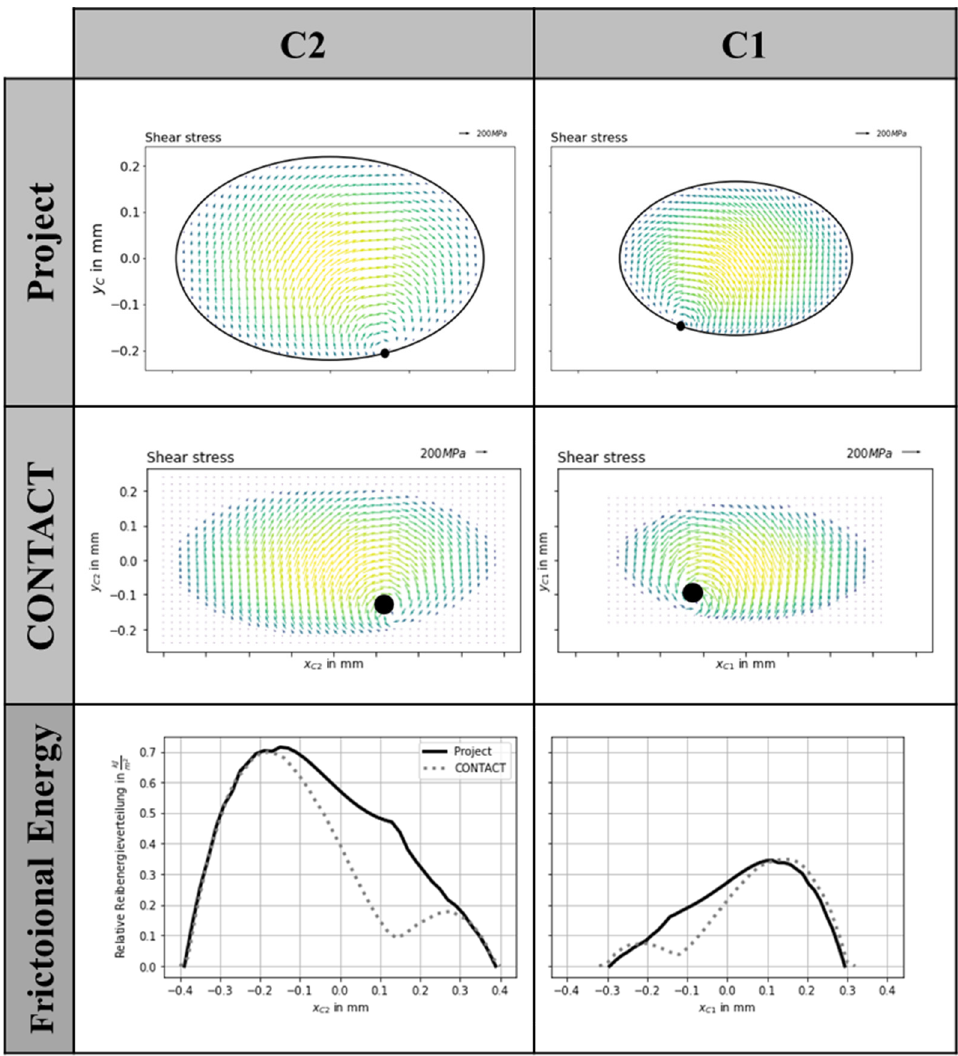
Figure 10. Resulting shear stresses and frictional energy; steel/steel, F rad = 200 N, F ax = 30 N, µ = 0.3, F Motor = − 30